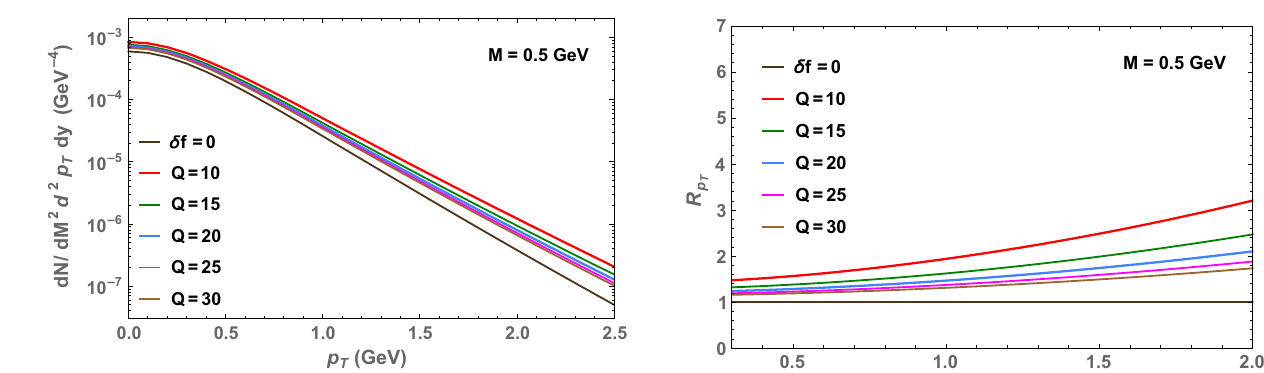
Fig. 3 Strength of non-equilibrium corrections to equilibrium yield represented through ratio R p